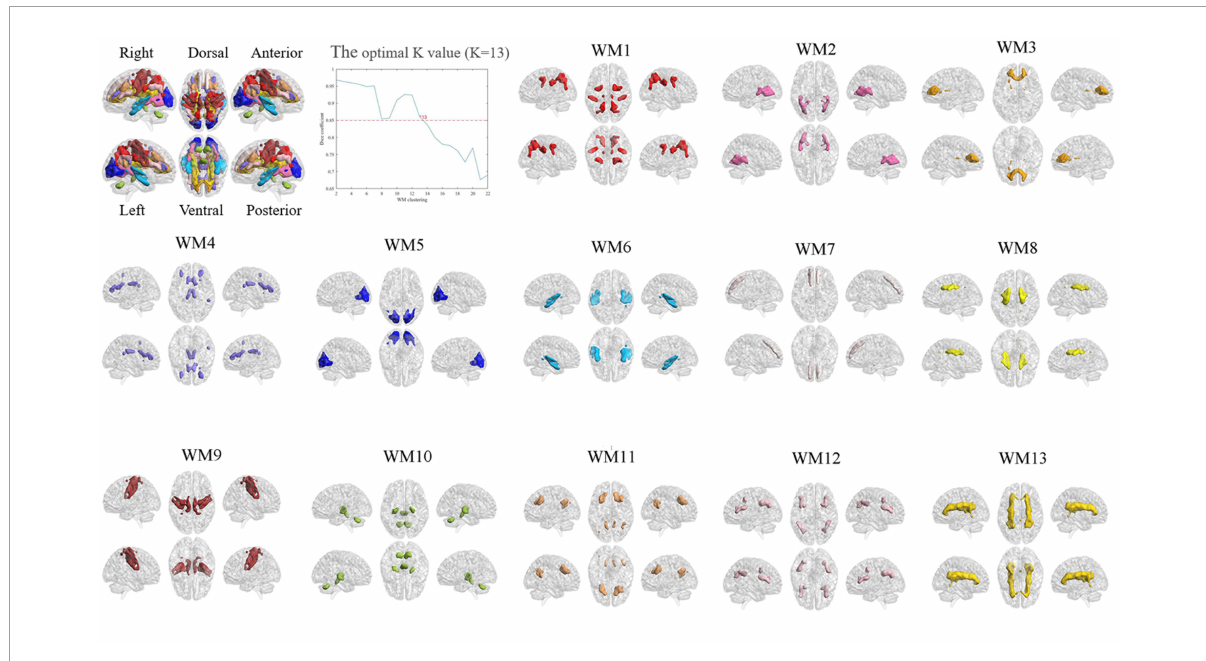
FIGURE2 The optimal K-value and functional white-matter networks. WM1 (superior longitudinal fasciculus network), WM2 (inferior longitudinal fasciculus network), WM3 (anterior corpus callosum network), WM4 (corpus callosum network), WM5 (occipital network), WM6 (inferior temporal), WM7 (prefrontal network), WM8 (superior corona radiata network), WM9 (post-central network), WM10 (cerebellar network), WM11 (posterior callosum network), WM12 (inferior frontoparietal network), and WM13 (deep network).